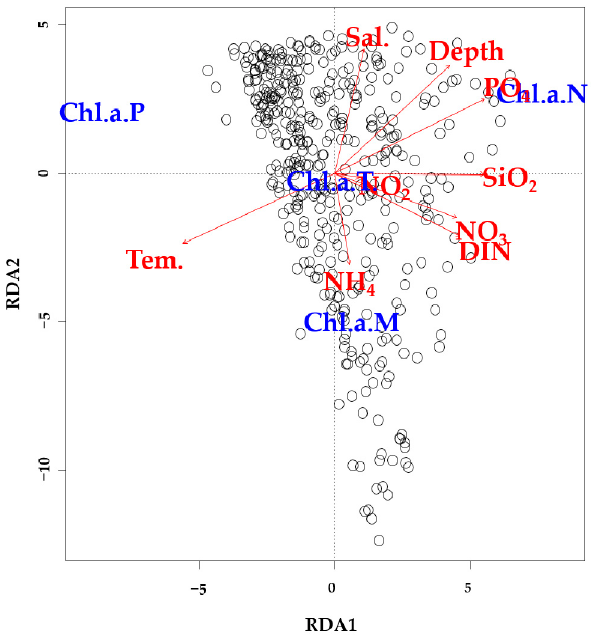
Figure 10. Redundancy analysis (RDA) ordination plots showing relationships between environmental and biological conditions in the northern East China Sea. Table 5. Size fractionation of phytoplankton observed in the different coastal waters of the northern East China Sea and global waters.